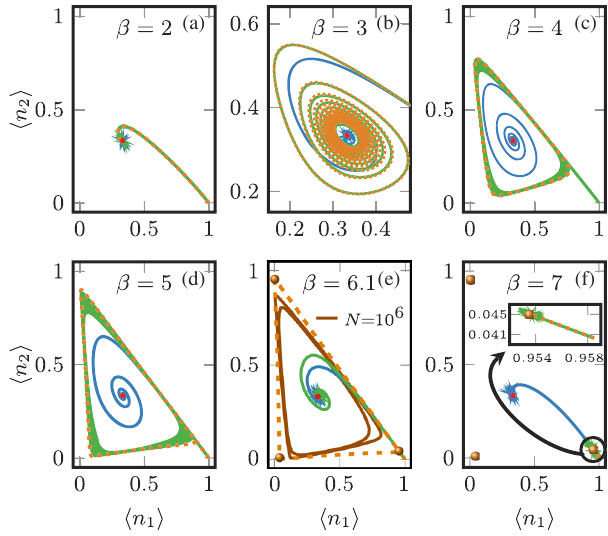
FIG. 8. Parametric plot of the mean occupation densities h n different finite system sizes N ¼ 10 2 (blue solid line), N ¼ 10 4 (green solid line), and the MF limit ( N ¼ ∞ , orange dotted line) at distinct values of β . In all panels, we initialize the system in the ground state with n 1 ¼ 1 and sample 10 6